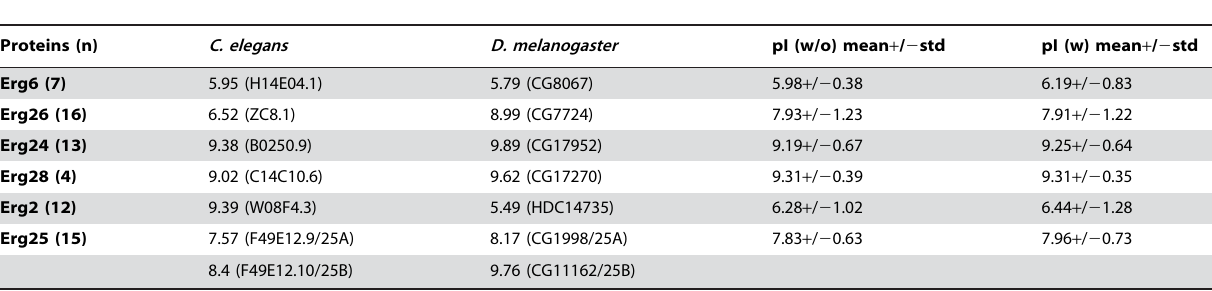
Table 2. Isoelectric points (pI) of the ERGp orthologs in C. elegans and D. melanogaster .